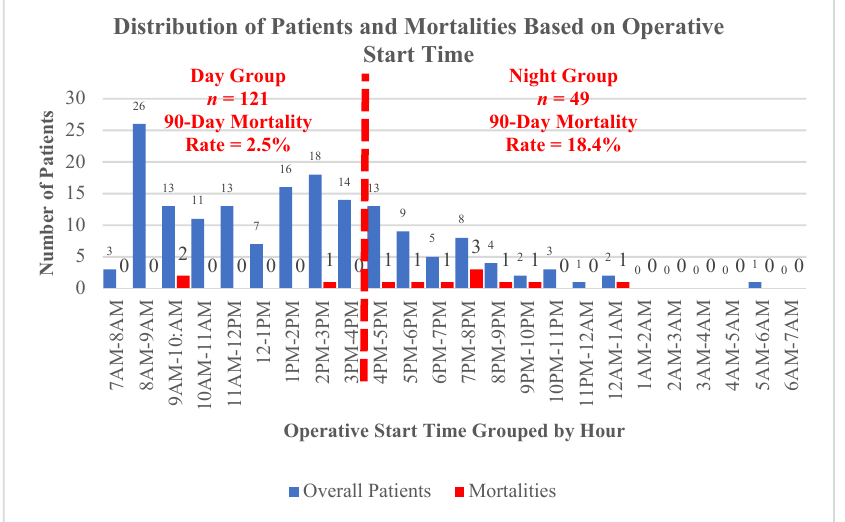
Figure 1. Distribution of patients and mortalities based on operative start time. Day operation group (7 a.m. to 4 p.m.) consisted of 121 patients with a 2.5% 90-day mortality rate. Night operation group (4 p.m. to 7 a.m.) consisted of 49 patients with an 18.4% 90-day mortality rate.